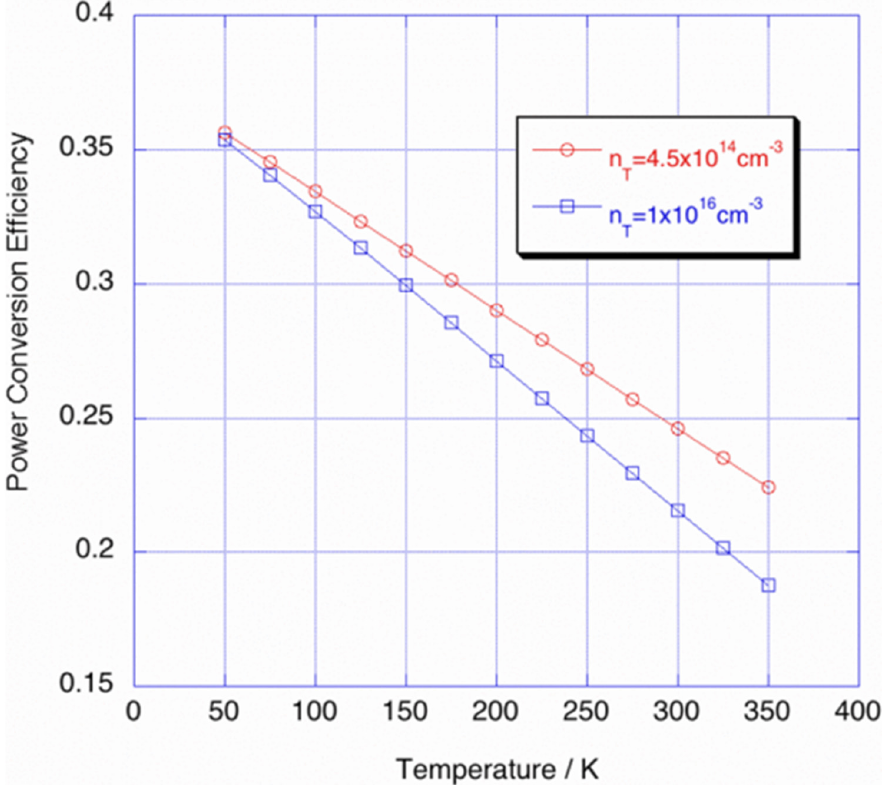
Figure 43. Efficiency of solar cells vs. temperature, with trap densities [170].